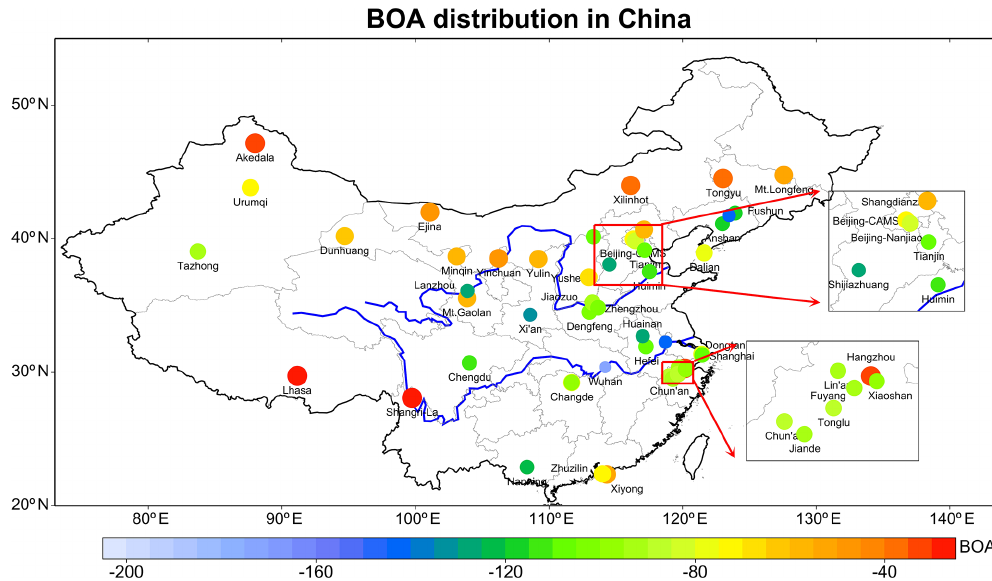
Figure 7. Annual spatial distribution of direct aerosol radiative effect at the bottom of the atmosphere at the CARSNET sites.